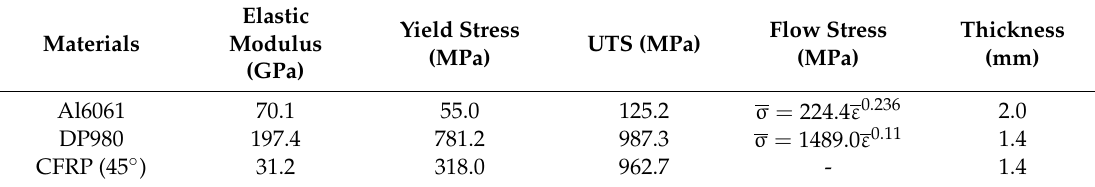
Figure 2. Failure mechanisms of hole clinched joint under pull-out loading condition. Table 1. Mechanical properties of upper and lower